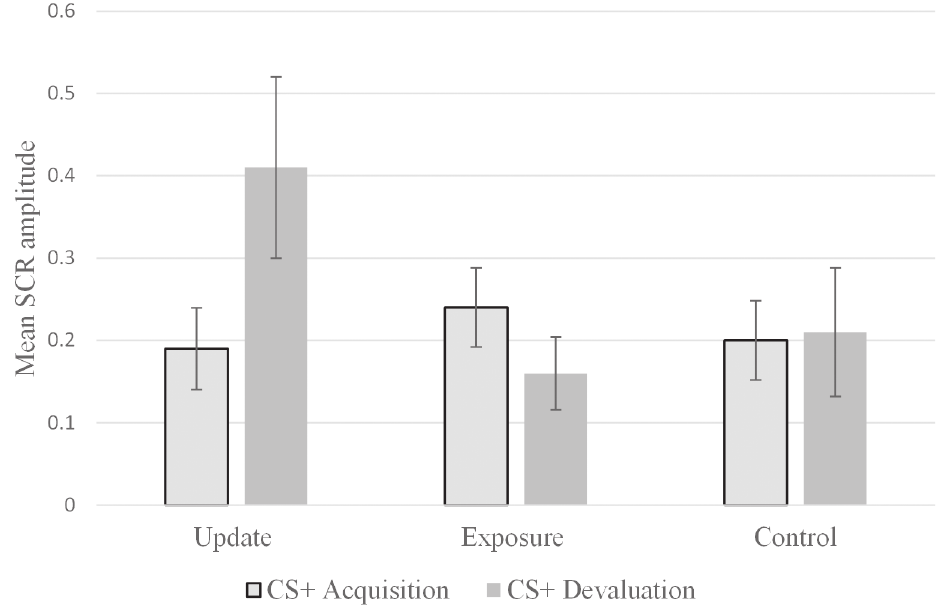
Fig 2. Verbally updating the trauma memory increases SCR response to CS+. A significantly larger increase in SCR to the CS+ from acquisition to US devaluation was found in the update as opposed to the exposure and control groups. The three groups were equivalent at acquisition. Error bars represent bootstrapped standard